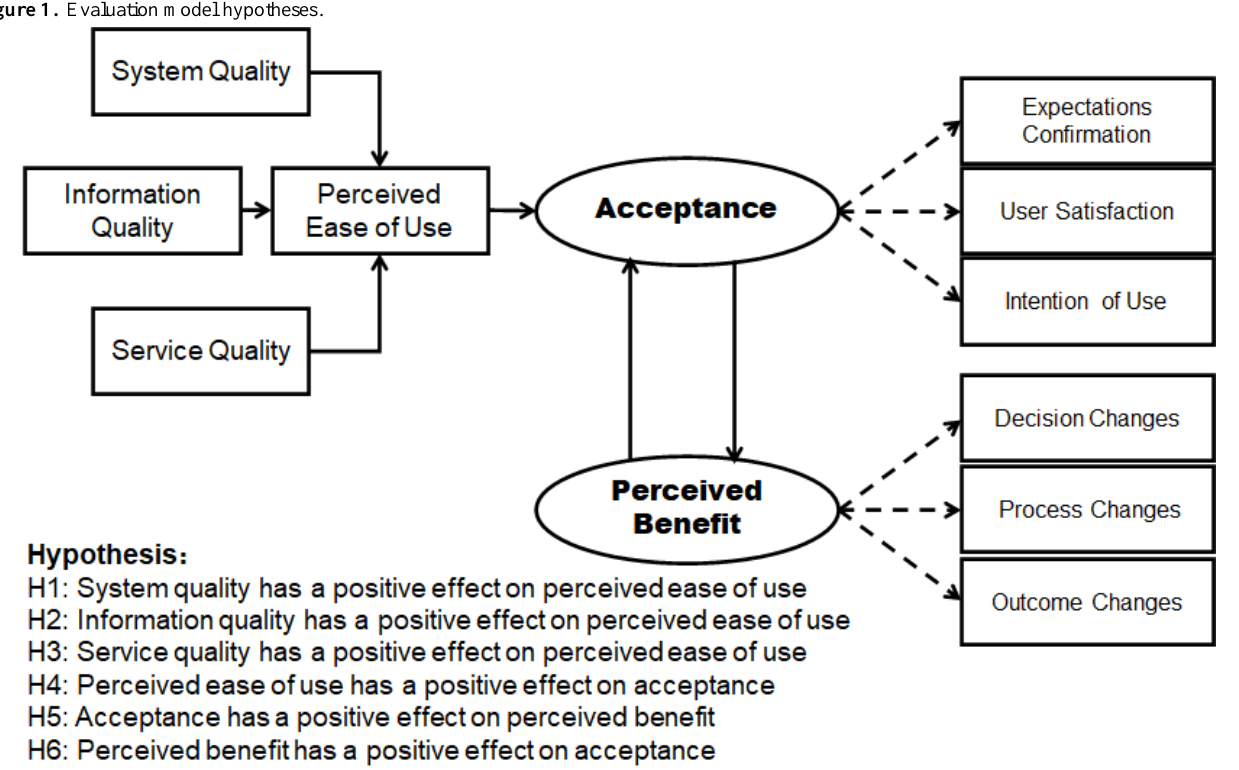
Figure 1. Evaluation model